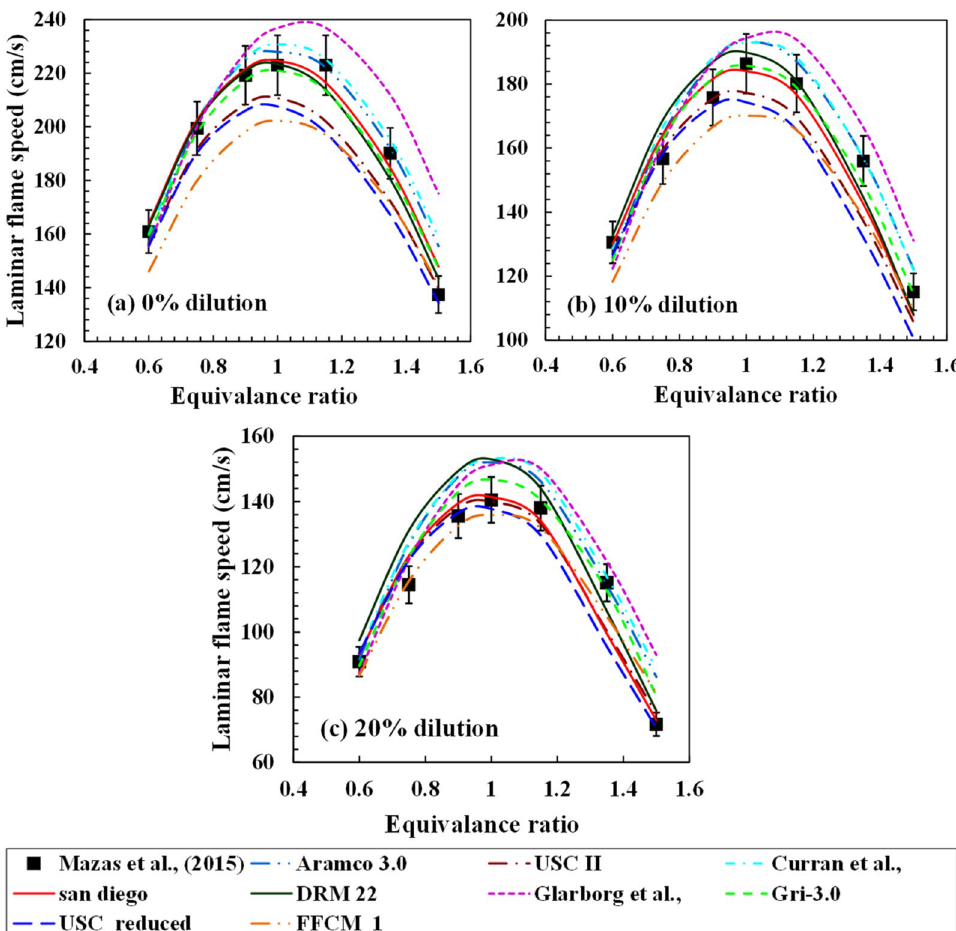
Figure 9. Laminar flame speed for CH 4 /O 2 /N 2 /H 2 O mixture at an unburned gas temperature of 373 K and atmospheric pressure with oxygen enrichment of 0.5 for ( a ) 0% ( b ) 10% and ( c ) 20% steam